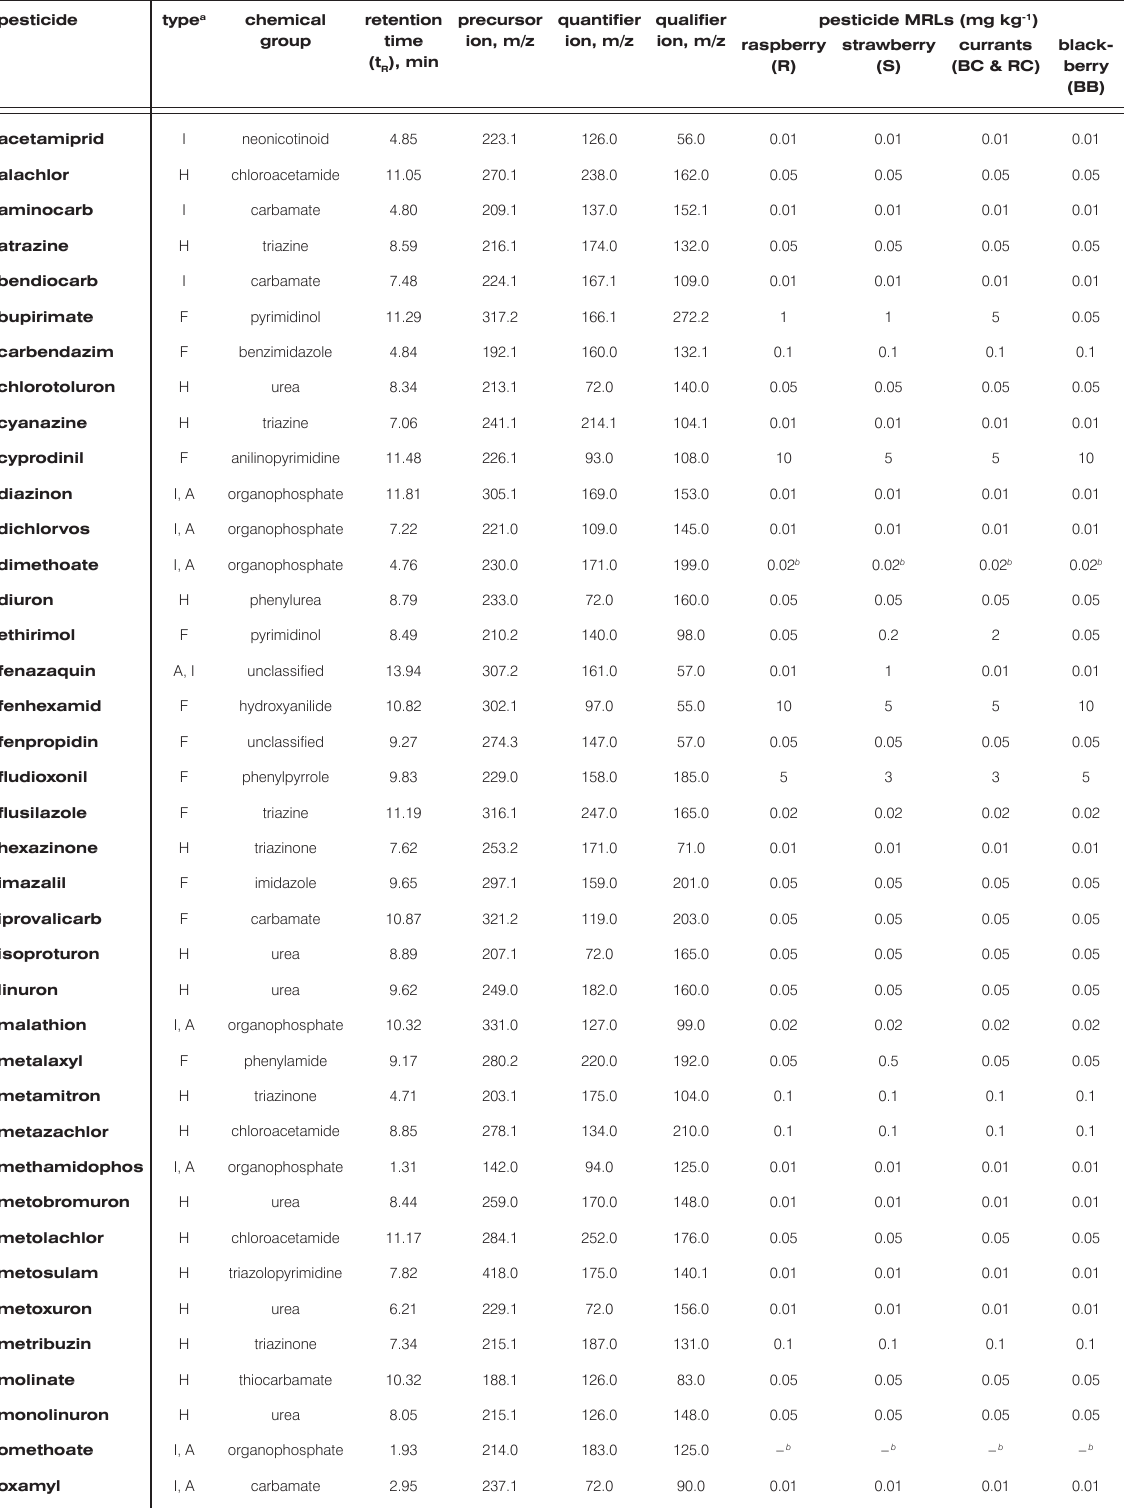
Table 1. Pesticide retention times, MRM transitions and maximum residue levels (MRL) for raspberries, strawberries, black and red currants and blackberries. pesticide